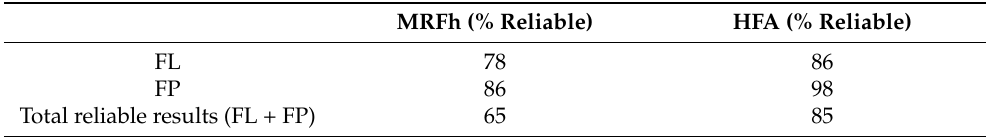
Table 3. Telemedicine test of reliability for n = 20 glaucoma participants. MRFh (% Reliable) HFA (% Reliable) FL 78 86 FP 86 98 Total reliable results (FL + FP) 65 85